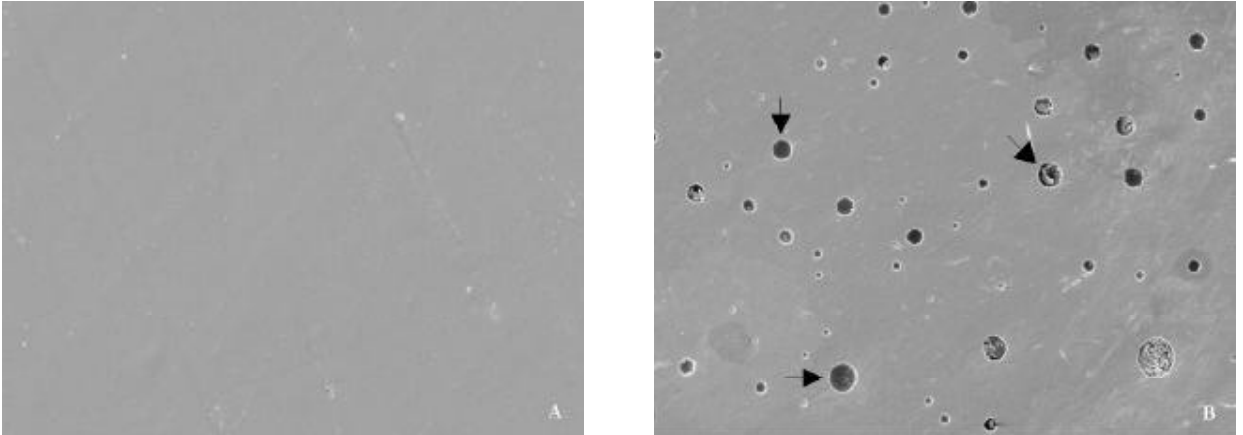
FIGURE 1 - A110 conventional composite: (A) after polishing with Sof-Lex discs and before the mechanical toothbrushing test; (B) after the mechanical toothbrushing test. The arrows show the surface porosities of the composite sample. Original magnification 2500x